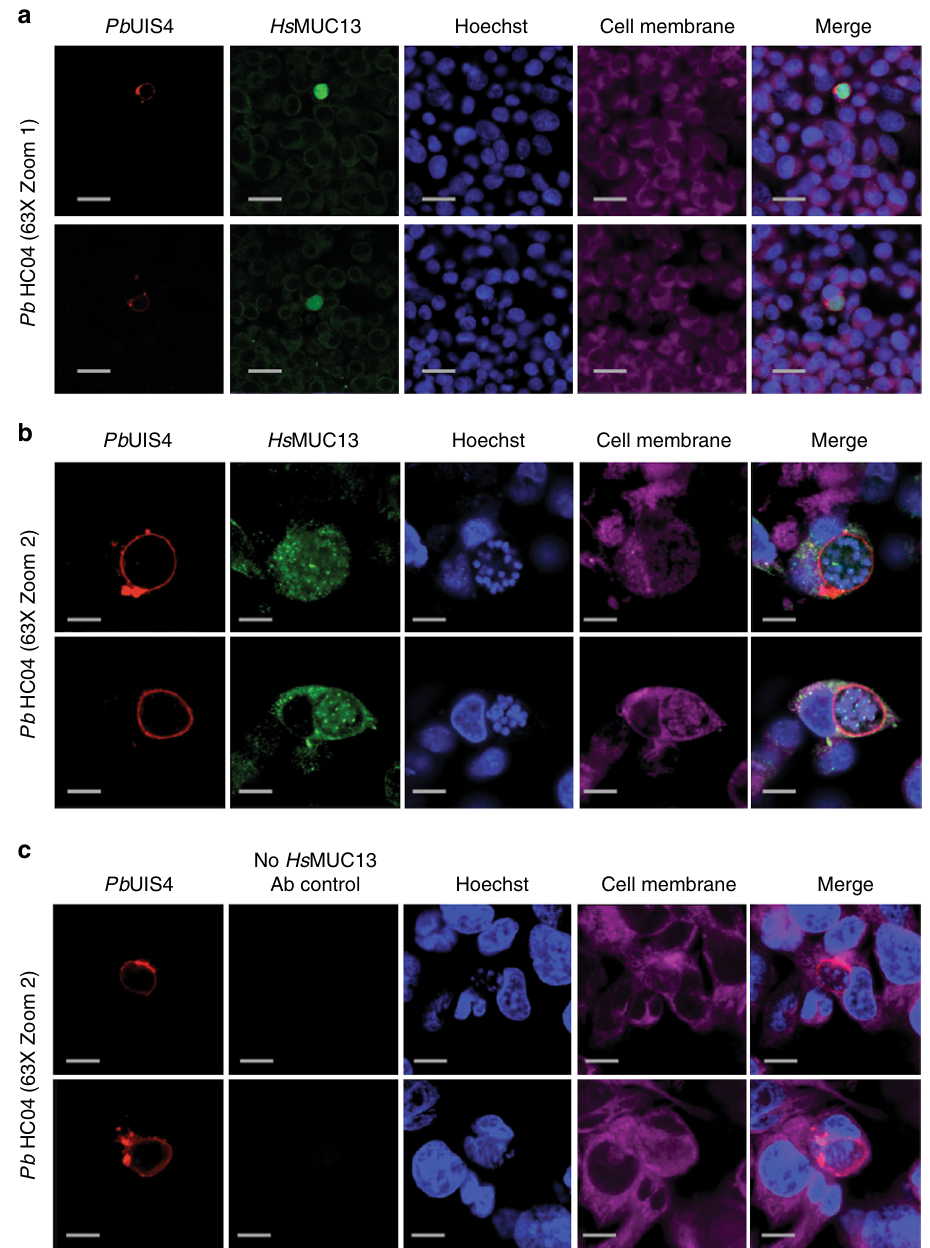
Fig. 2 Expression and localization of MUC13 in Plasmodium infected hepatoma cells. a , b Confocal microscopy images of representative HC04 liver cells infected with Plasmodium parasites 48 hpi at two different magni fi cations. c Control Confocal microscopy images of representative HC04 liver cells infected with Plasmodium parasites 48 hpi without MUC13 antibody being used. Cells were labeled using a rabbit polyclonal antibody (dilution 1:500, 1 mg/ml stock) against the intracellular region of MUC13 (MUC13 antibody #1 — AbCAM #Ab65109) and visualized with a goat anti-rabbit Alexa Fluor 488 (green); CellMask deep red was used for plasma membranes (Cell Membrane — magenta). P. berghei EEFs were labeled using a goat polyclonal (dilution 1:200, 1 mg/ml stock) against Pb UIS4 (LS-204260, LifeSpan Biosciences) and visualized with a bovine anti-goat secondary antibody (Alexa Fluor 647, red), respectively. Nuclei were labeled with Hoechst 33342 (blue). Merged images between Hs MUC13, UIS4 and Hoechst are shown. Scale bars 50 (zoom 1) or 10 (zoom 2) μ m; 63× oil